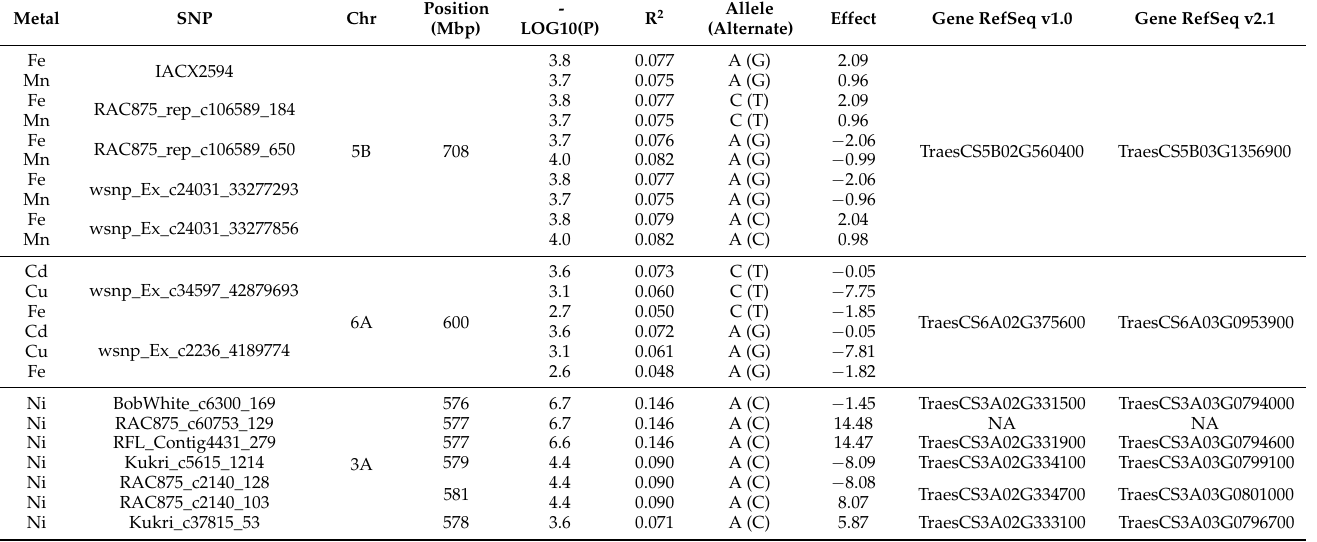
Figure 3. Manhattan plots representing association mapping for the 200 wheat genotypes using 26,814 SNPs for Mn ( A ), Fe ( B ), Cu ( C ), Zn ( D ), Ni ( E ), Cd ( F ). The horizontal axis represents the 21 wheat chromosomes, and the vertical axis represents the significance level − log10 ( P ) values. Table 3. Selected significant SNPs associated with some metals. Each SNP is detailed according to its chromosomal (Chr) position in megabase pairs (Mbp), significance value (–log10( P ) value), explained phenotypic variance (R 2 ), the effect of each allele, and its gene name in the first and second version of the wheat reference sequence (RefSeq), RefSeq v1.0 and RefSeq v2.1, respectively, announced by the International Wheat Genome Sequencing Consortium